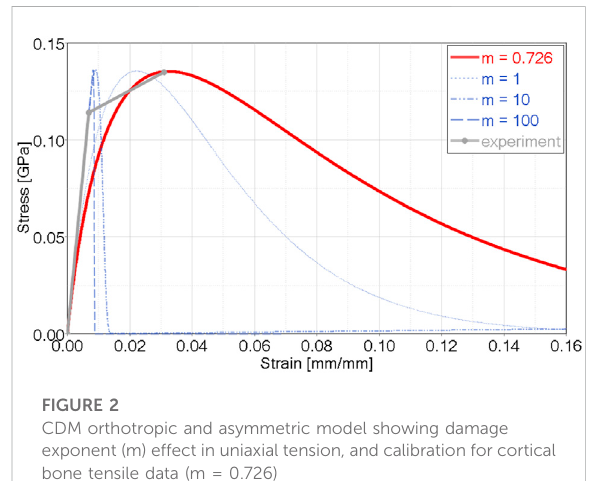
FIGURE 2 CDM orthotropic and asymmetric model showing damage exponent (m) effect in uniaxial tension, and calibration for cortical bone tensile data (m =